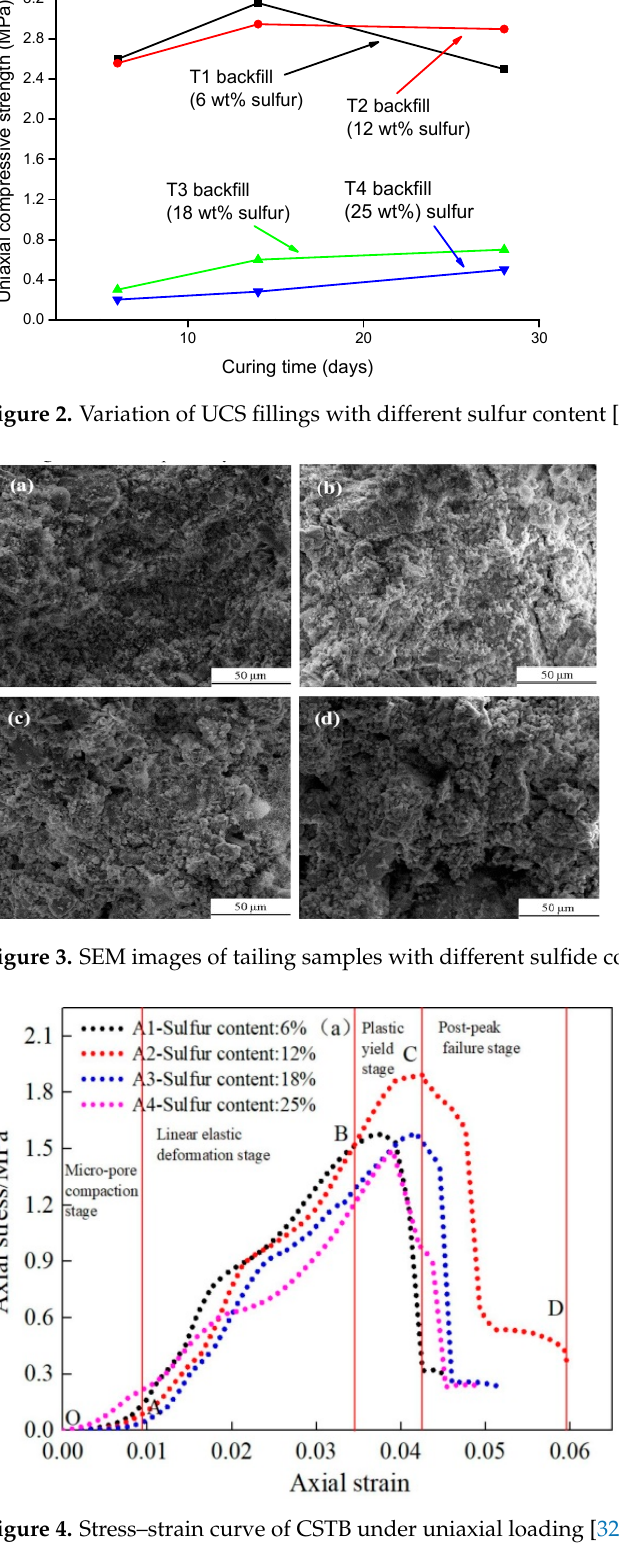
Figure 4. Stress–strain curve of CSTB under uniaxial loading [32].